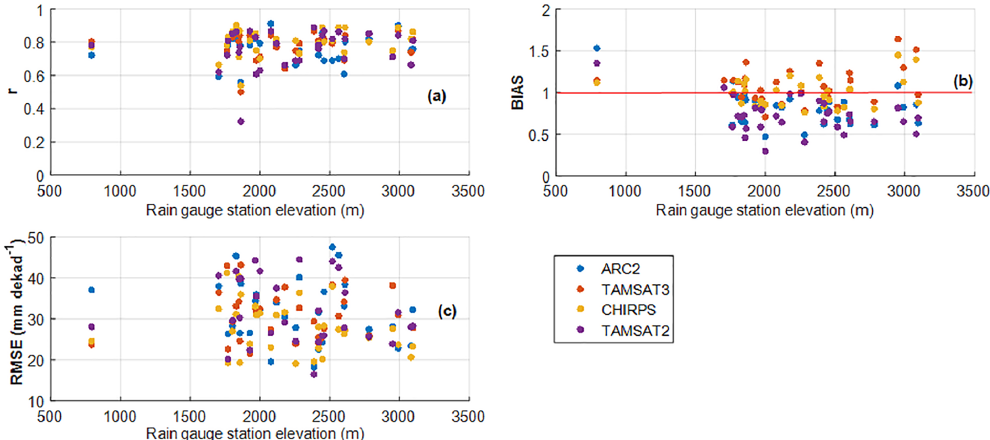
Figure 6. Statistical validation of the satellite products as a function of elevation: (a) Pearson correlation coefficient ( r ), (b) bias, and (c) the root mean square error (RMSE) over the Upper Blue Nile basin for the period of 2000–2015.